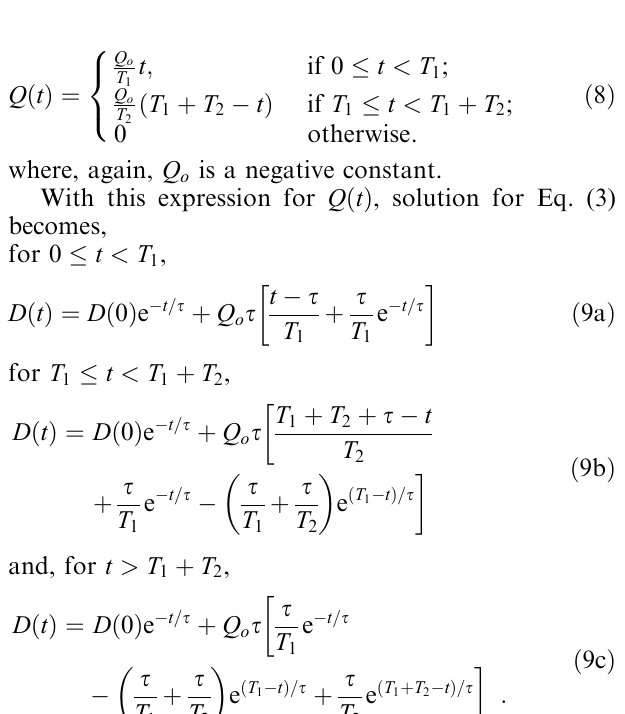
Fig. 2. Upper panel variation of the normal- ized peak value of D ( t ), j y (cid:133) s (cid:134)j (cid:136) j D p (cid:133) s (cid:134) = Q o j ; for the rectangular function of Fig. 1 as a function of s (Eq. 6b), for y o (cid:136) D (cid:133) 0 (cid:134) = Q o (cid:136) 0 : Lower panel variation of the characteristic times t p (a constant for the particular case of a rectangular input function), w and w 1 ; as functions of